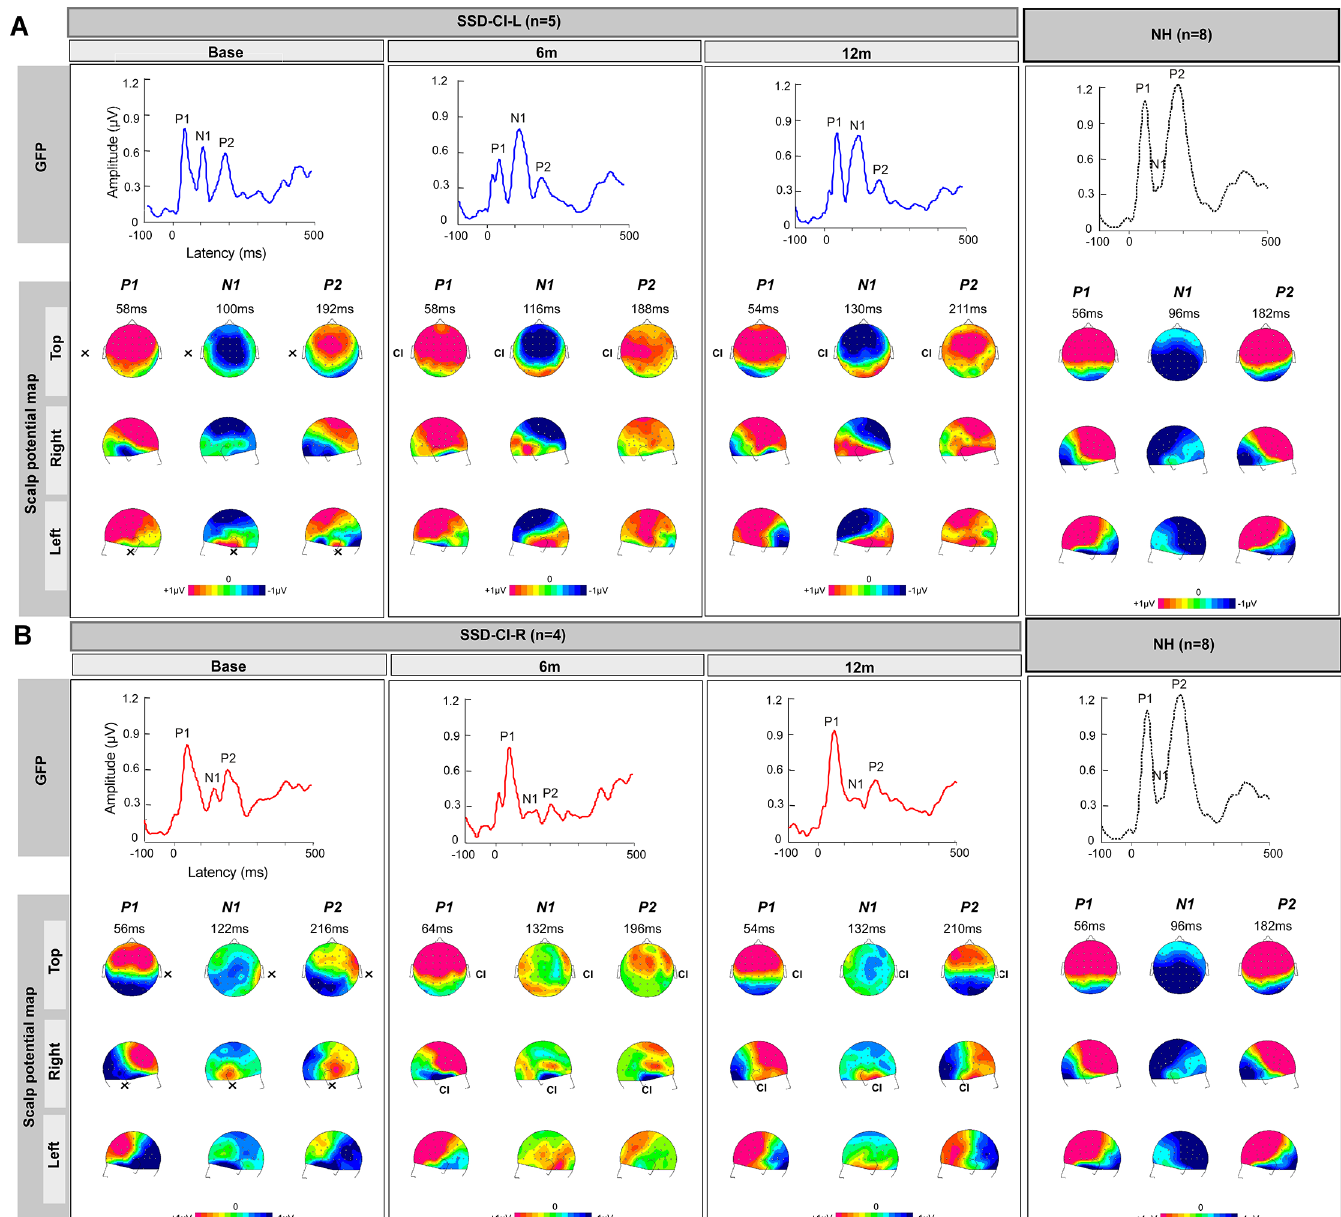
Fig 4. Evoked surface activity over time of CI stimulation (Base, 6m, 12m) for SSD-CI subjects and NH control group. (A) Top: Mean GFP for SSD-CI-L subjects (n = 5); NH GFP is shown at right. Bottom: mean scalp potential maps (right, top and left views) for P1, N1 and P2 peak latency; NH maps are shown at right. (B) Top: Mean GFP for SSD-CI-R subjects (n = 4); NH GFP is shown at right. Bottom: mean scalp potential maps (right, top and left views) for P1, N1 and P2 peak latency; NH maps are shown at